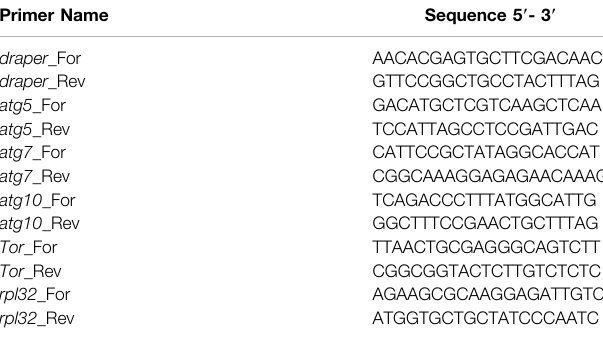
TABLE 1 | List of primers sequences used in the